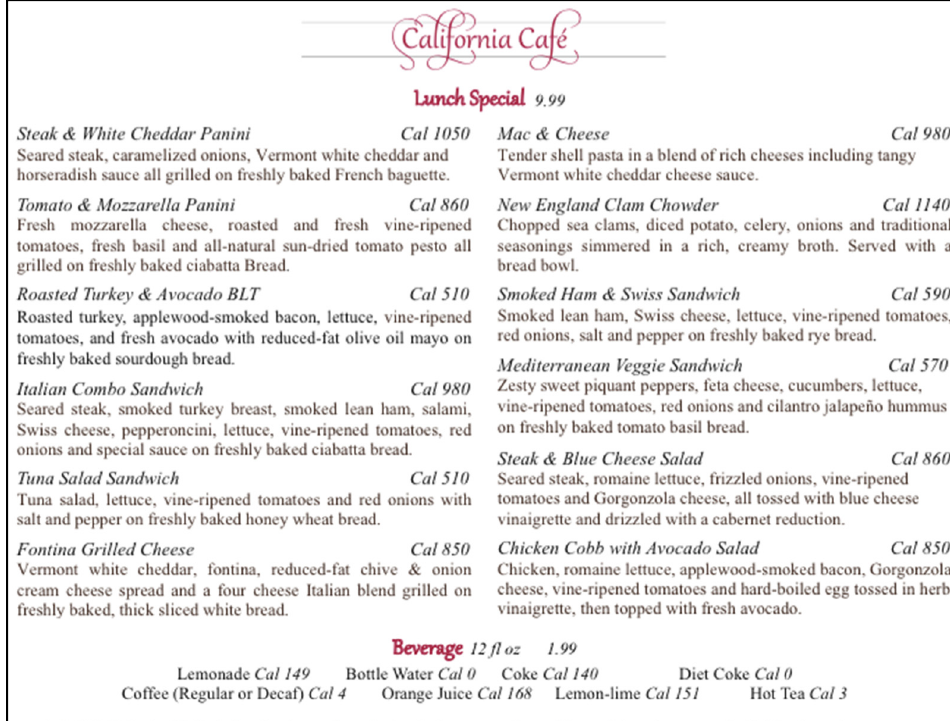
Figure A4. Asian Fusion Light and Fresh Menu.